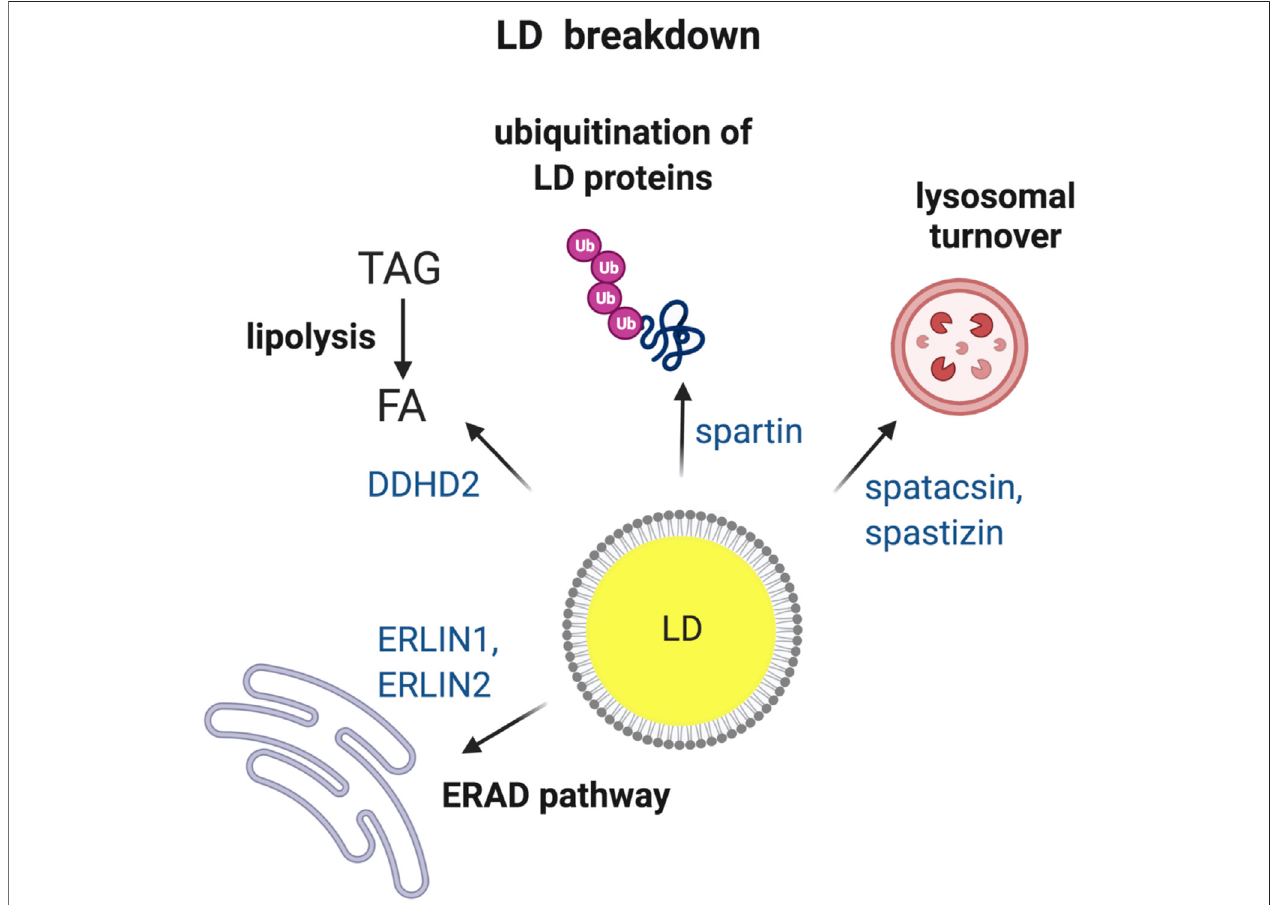
FIGURE 2 | HSP proteins involved in the breakdown of LDs. Turnover of LDs via four different pathways i.e., (1) ER-associated degradation (ERAD); (2) TAG hydrolysis by lipases; (3) ubiquitin-mediated degradation of speci fi c LD proteins and (4) breakdown of LDs by lysosomes via autophagy. HSP-associated proteins involved in each of the different pathways are indicated. Made with